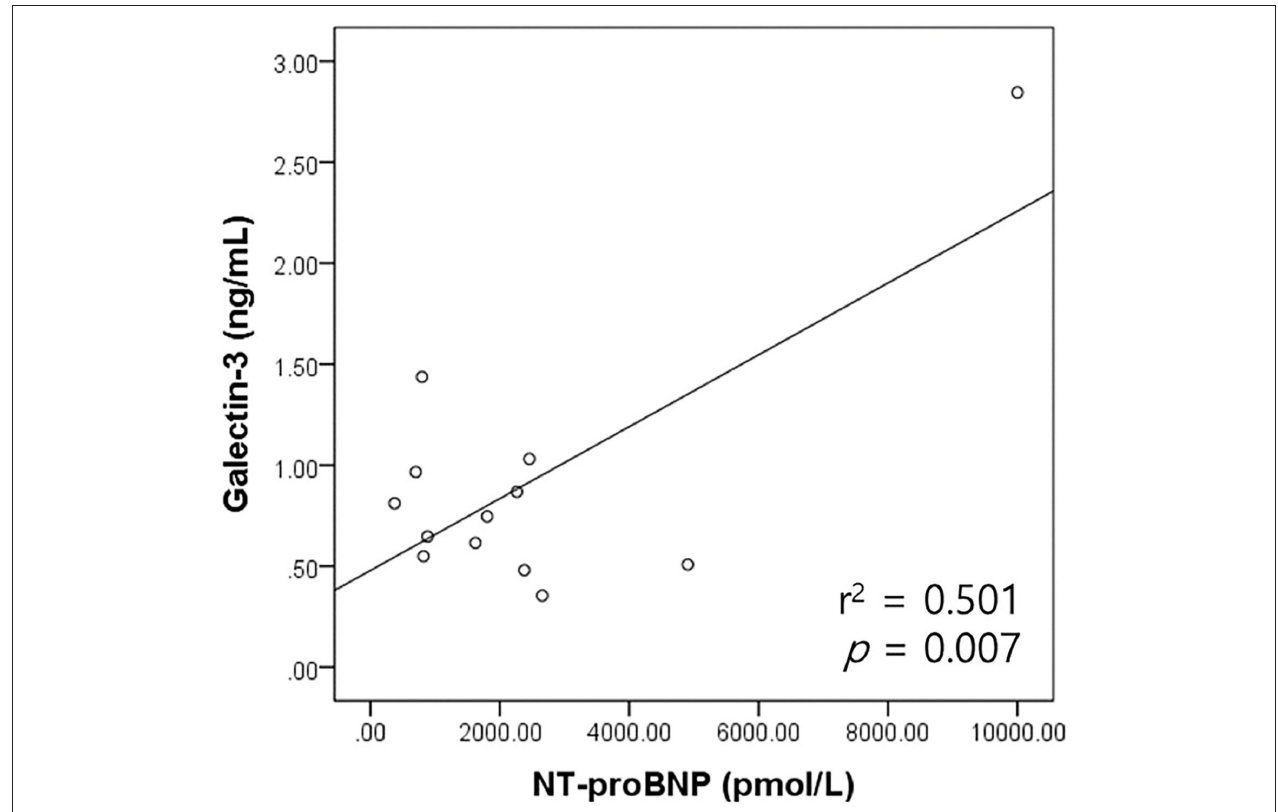
FIGURE 4 | Scatter plot of the bivariate correlation analysis between the NT-proBNP and galectin-3 levels in dogs with MMVD. NT-proBNP levels had a significant positive correlation with galectin-3 levels in dogs with MMVD ( p = 0.007). MMVD, myxomatous mitral valve disease; NT-proBNP, N-terminal pro-B-type natriuretic